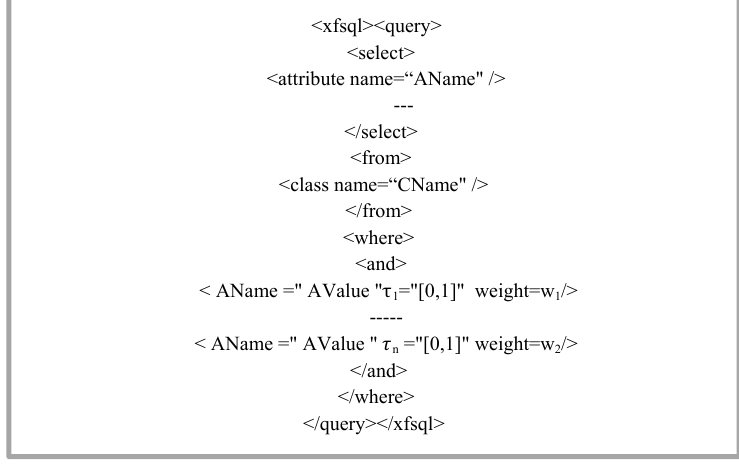
Fig. 5. Conjunctive query syntax with XML